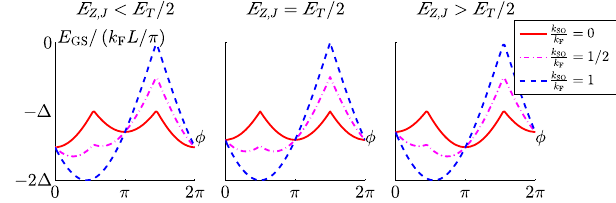
FIG. 11. The ground-state energy of the junction as a function of the phase difference ϕ in the limit of a narrow junction with a > k single bound state for all k [see Eq. (16)]. For k , at x F SO E E = 2 , the system undergoes a first-order phase transition Z;J ¼ T as the ground state shifts between the two local minima. In the left 0 . 45 E panel, E , and the system is in the trivial phase in its Z;J ¼ T 0 . 55 E , and the system is ground state. In the right panel, E Z;J ¼ T in the topological phase in its ground